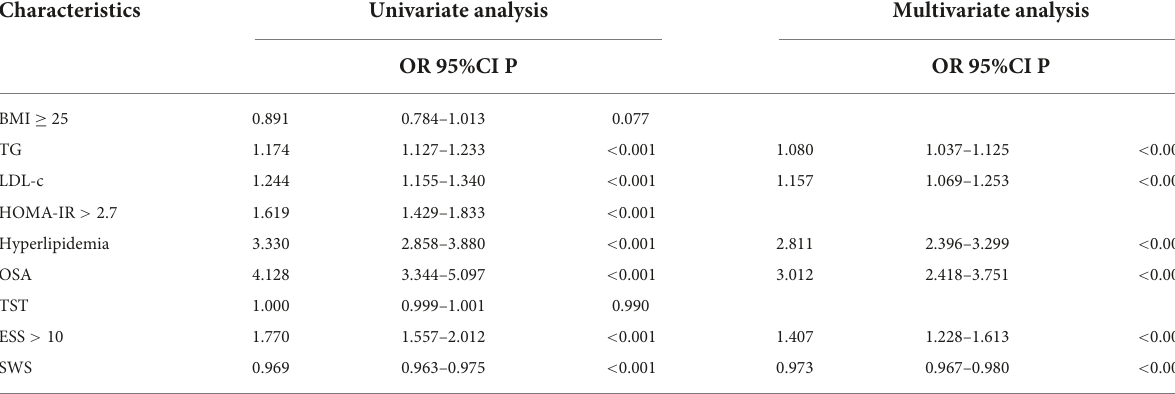
TABLE 2 Logistic regression analysis of factors associated with a moderate-to-high Framingham CVD risk in overall participants. Characteristics